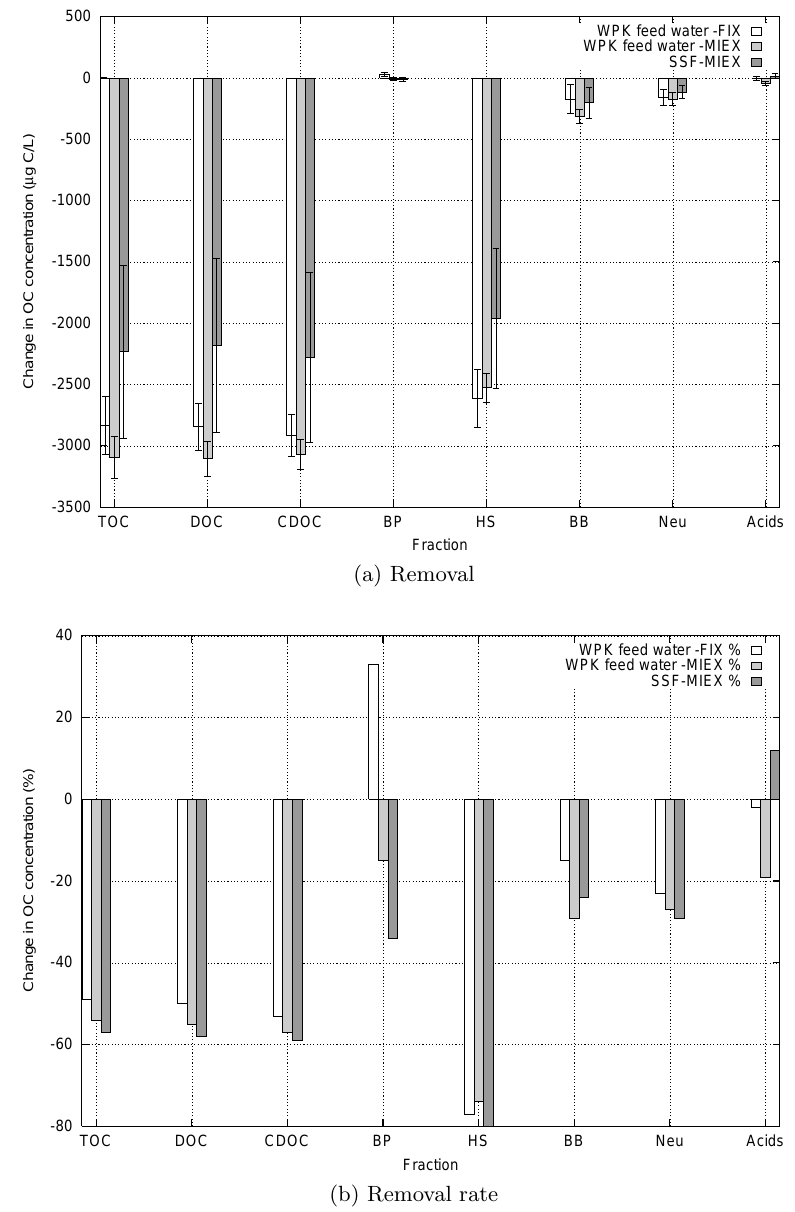
Figure 3: Change in NOM fraction concentrations in the different water Figure 3. Change in NOM fraction concentrations in the di ff erent water types by MIEX ® and FIX. types by MIEX R (cid:2) and FIX before coagulation. The cheapest option is to place IEX